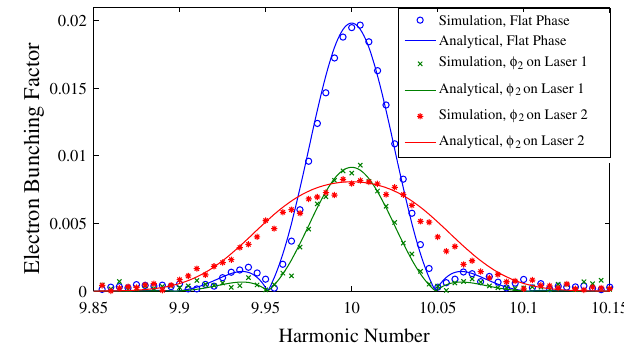
FIG. 9. Schematic of EEHG phase space. Phase errors on the first stage distort the separation of density spikes within a single modulation wavelength (solid blue arrows), but the length of each group (dotted red arrows) is phase locked by the second stage. Phase errors on the second stage, by contrast, can change the final seeded